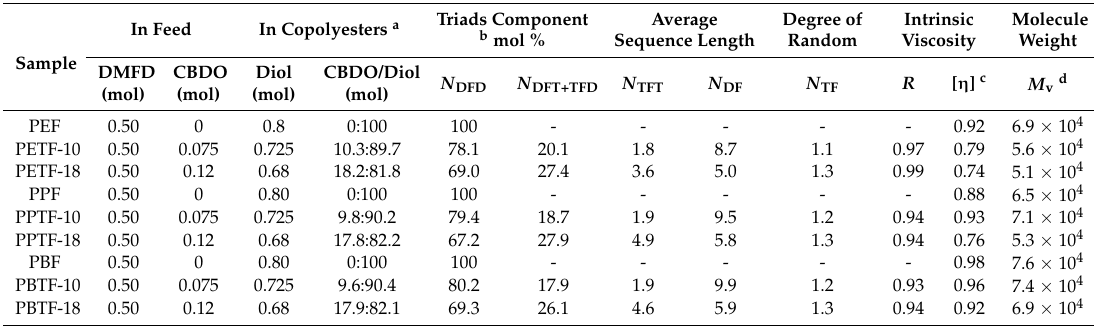
Scheme 1. Synthesis and chemical structures of different copolyesters. Table 1. Composition and sequence distribution of the synthesized copolyesters.